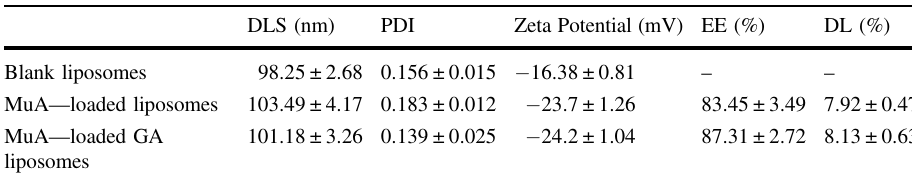
Table 1 Characteristics of various types of liposomes (mean ±